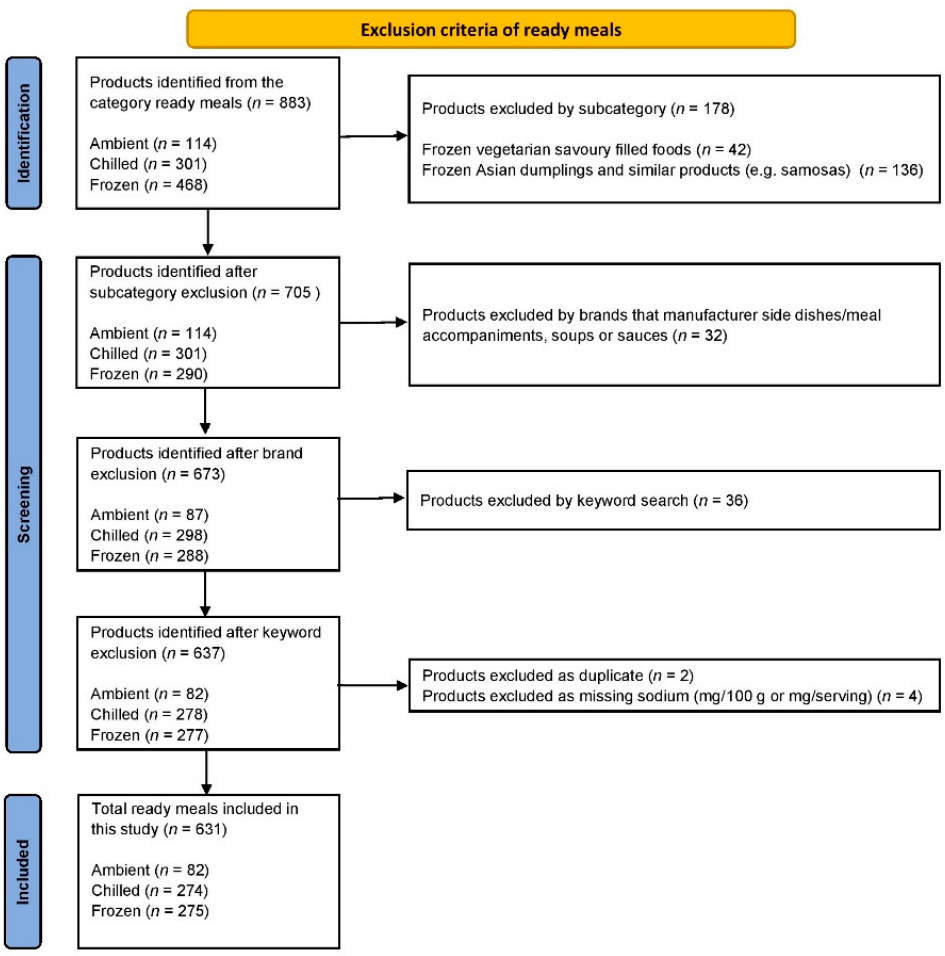
Figure 1. A flow diagram of excluded products.